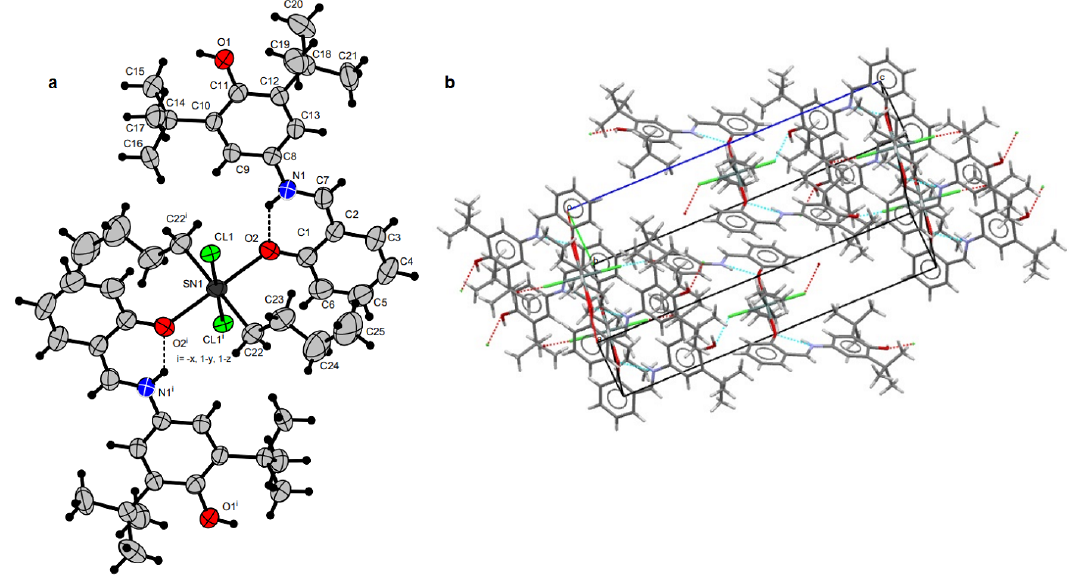
Figure 3. Molecular structure of 2 ( a ); hydrogen bonds in crystal packing 2 ( b ).